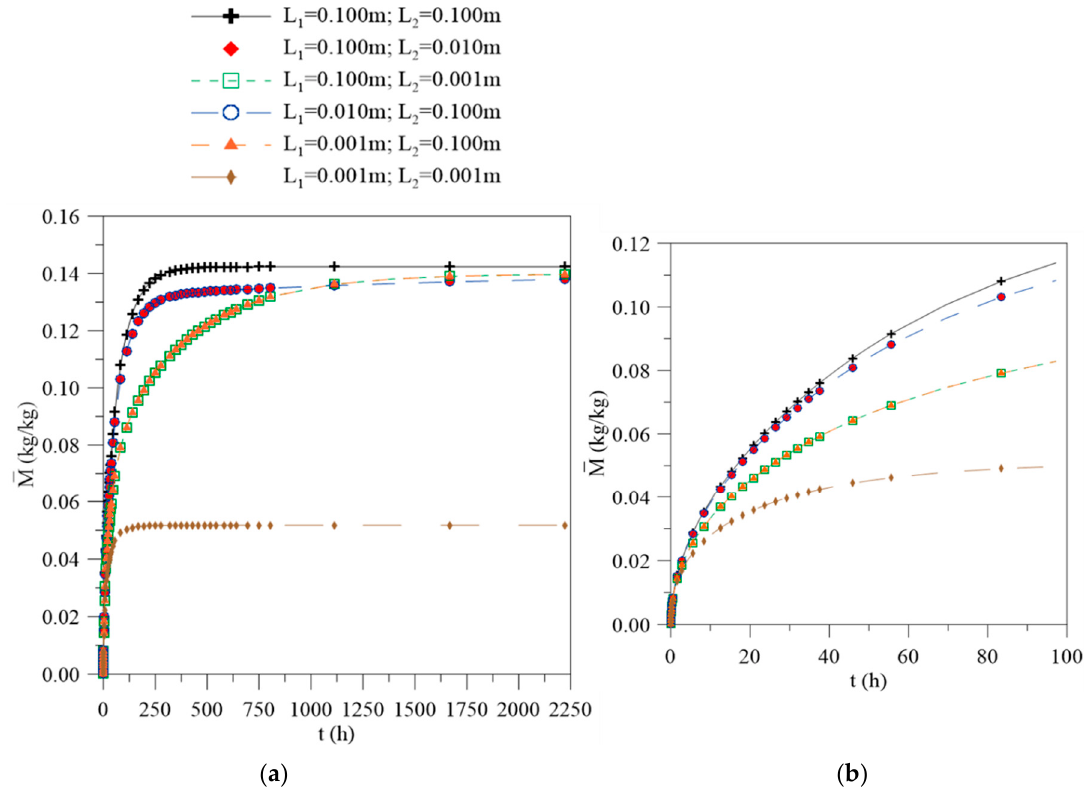
Figure 3. ( a ) Average moisture content as a function of the process time for different physical saturations. ( b ) Detailed view of ( a ).